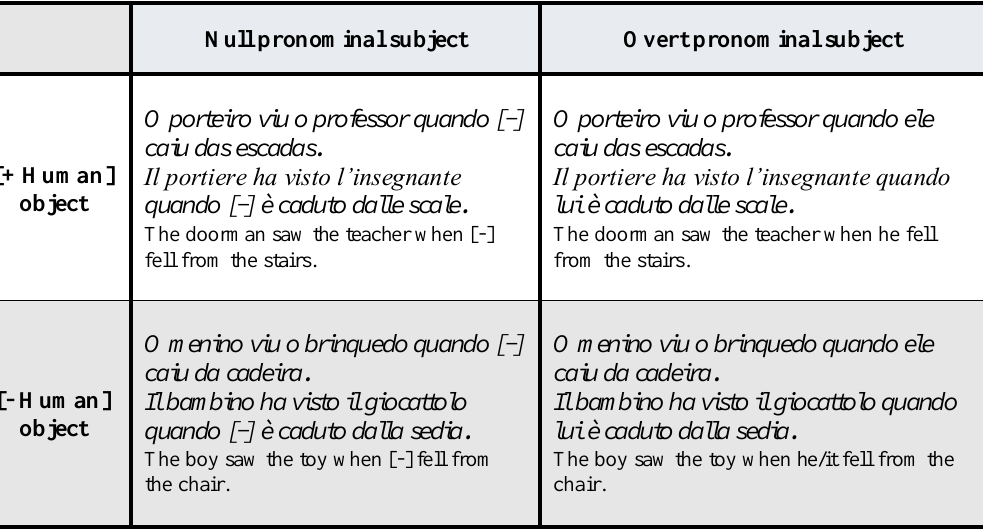
Table 2. Example of test